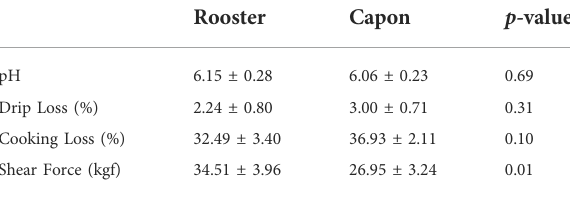
TABLE 1 Difference of meat quality between capons and roosters. Rooster